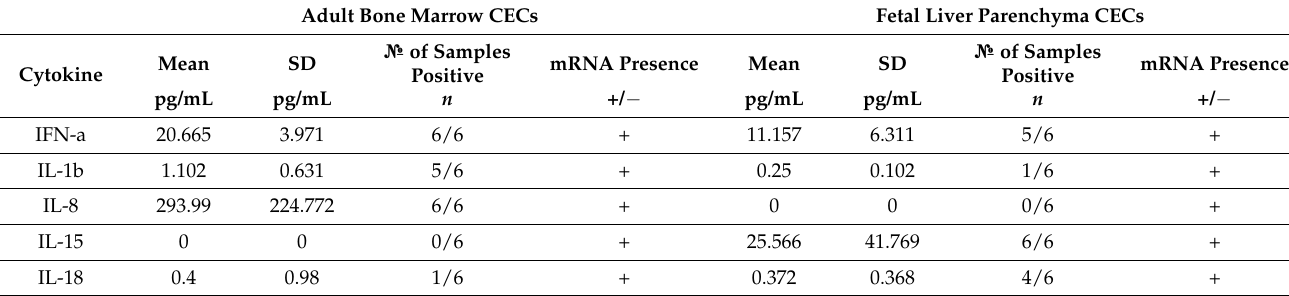
Table 2. Concentration of cytokines in CECs’ culture medium ( n = 6). Data are presented as mean ± SD, number of samples containing the cytokine, either presence (+), absence ( − ) of the corresponding mRNAs in CECs. Data of main interest are shown in